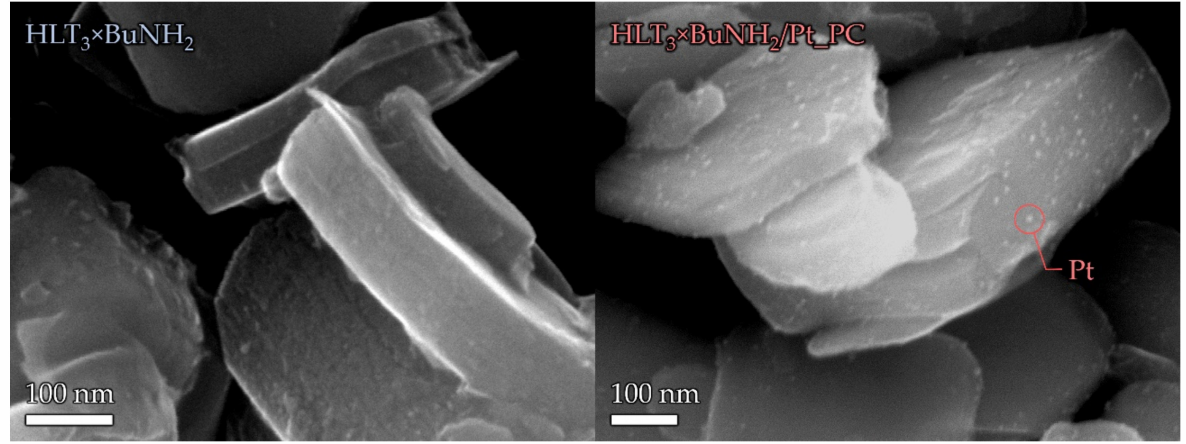
Figure 4. SEM images of the n -butylamine-intercalated titanate before (HLT 3 × BuNH 2 ) and after (HLT 3 × BuNH 2 /Pt_PC) the photocatalytic